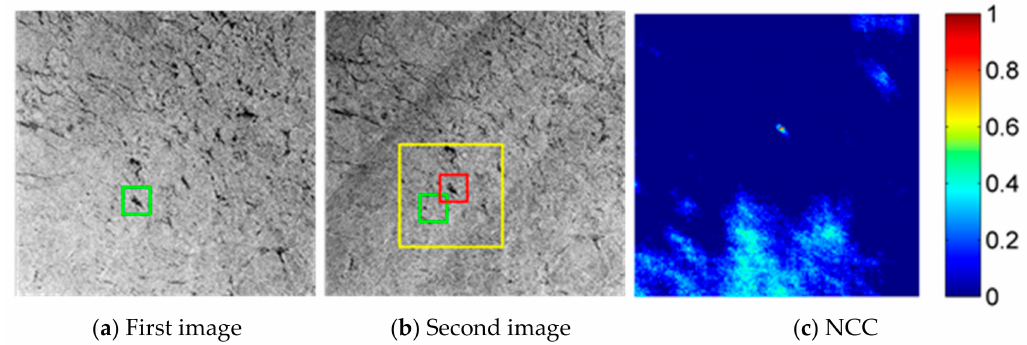
Figure 6. Illustration of the maximum cross-correlation (MCC) method. ( a ) First image. ( b ) Second image. ( c ) The cross-correlation matrix between sub-image with a green empty square and the sub-image with a yellow empty